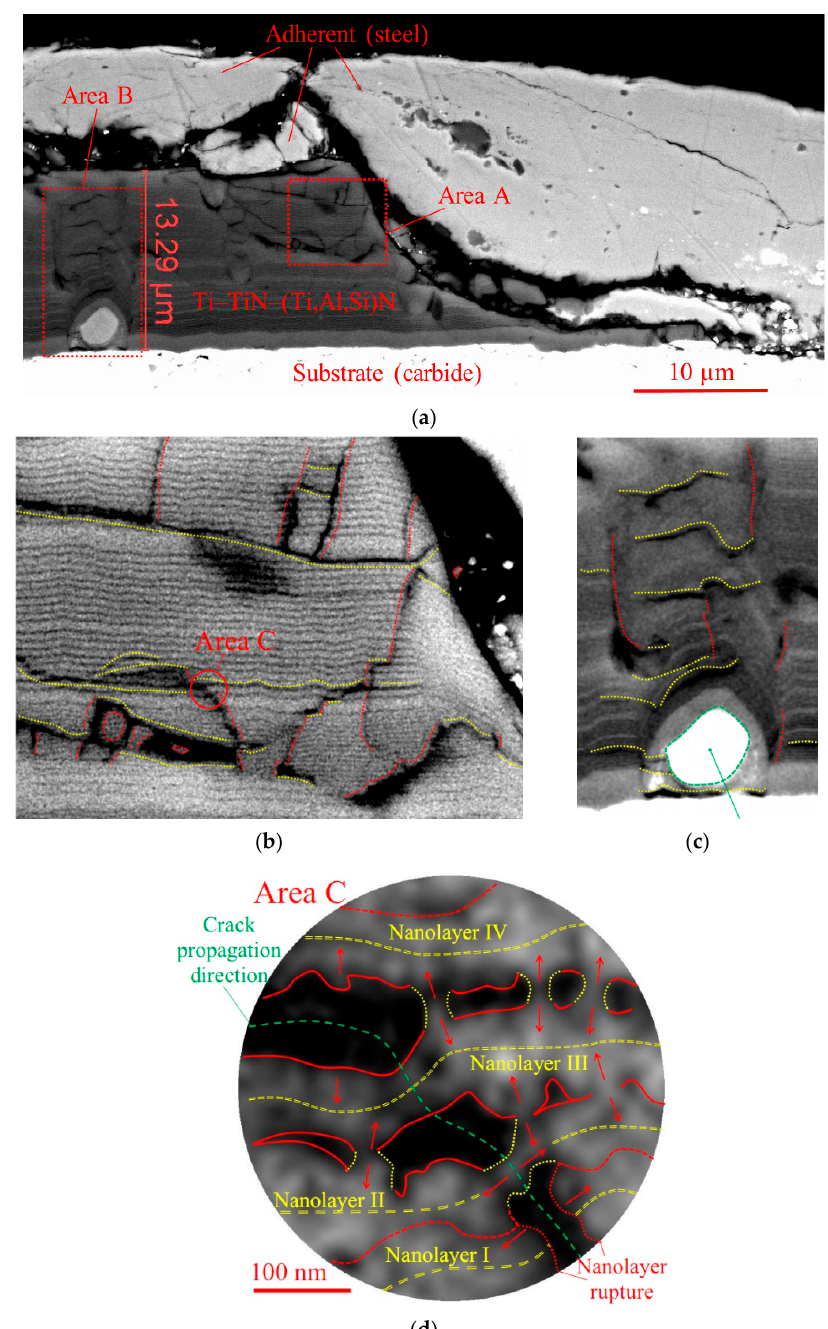
Figure 21. Mechanism of wear and failure for the cutting tool with coating S7: General view of the cross section at the border of the wear crater ( a ); Area A: Destruction of the coating at the boundary of the wear crater ( b ); ( c ) Area B: Microdroplets embedded in the structure of the coating; ( d ) Area C: Crack propagation is inhibited by adhesion bridges between sub-nanolayers (denoted by a yellow-dotted line, while arrows indicate internal tension stresses).